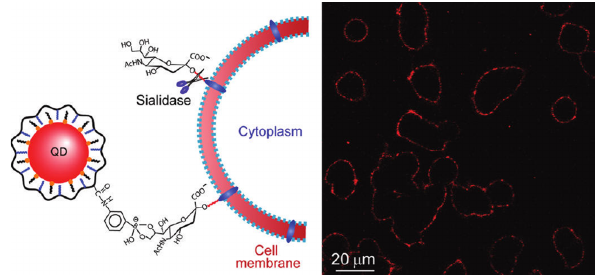
Figure 11: Specific binding of QD with SA on living cells at the C-8,9 diol of SA. Reprinted with permission from [62]. Copyright 2011,